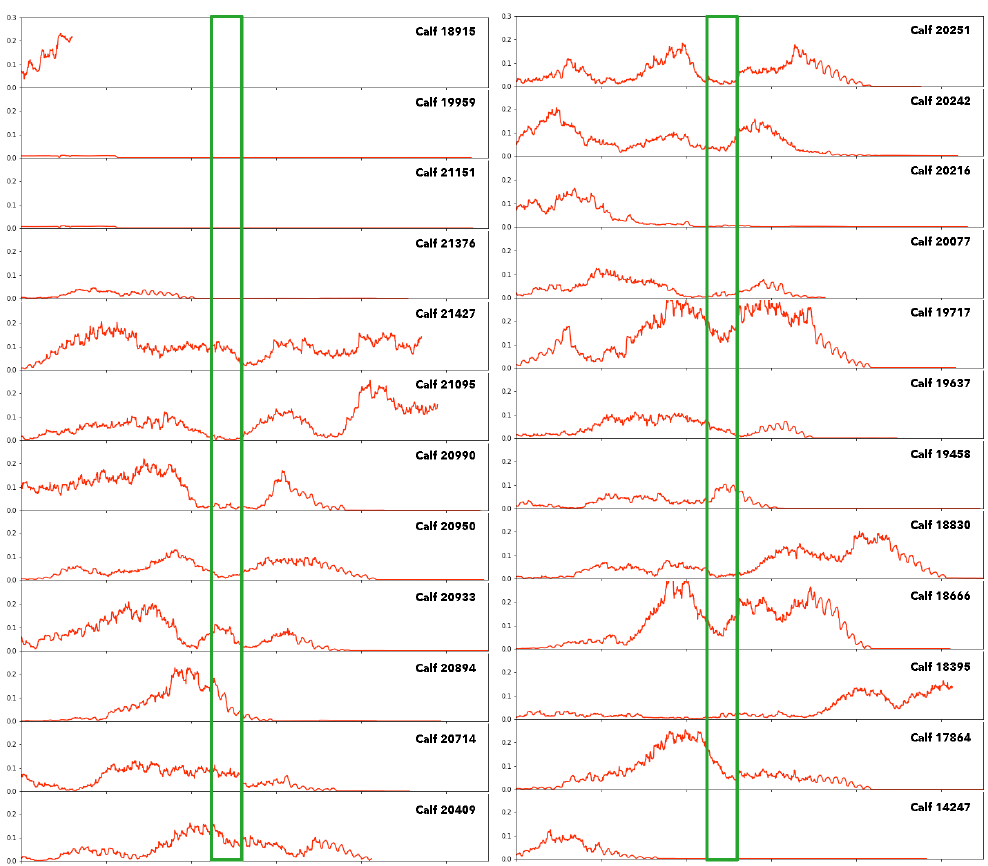
Figure 5. Line graphs of calf periodicity intensities for each of the 24 calves. Frequency is 24 h, window size is 7 days and window shift is 15 min. The vertical green lines indicate the dates of disbudding.